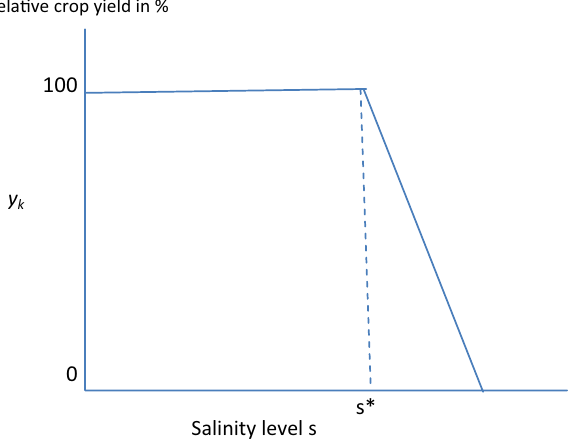
Fig. 3 Linear dependency between yield ( y ) and area ( A z ) for three land suitability classes ( z ) Fig. 4 Relation between salinity and relative crop yield. s * indicates tolerable salinity